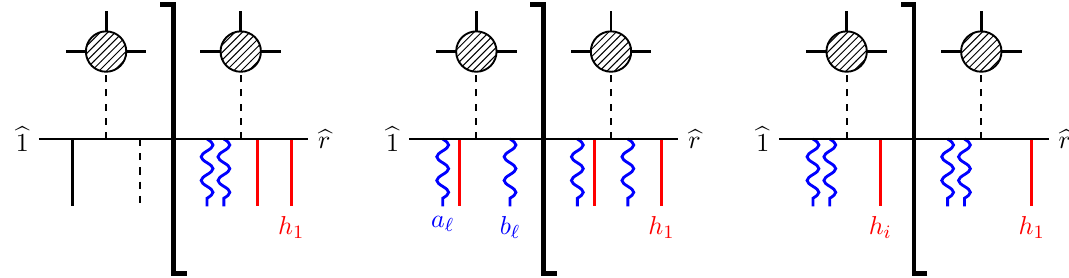
Figure 3 . Three possible factorization channels of (9.6) with h 1 2 H R